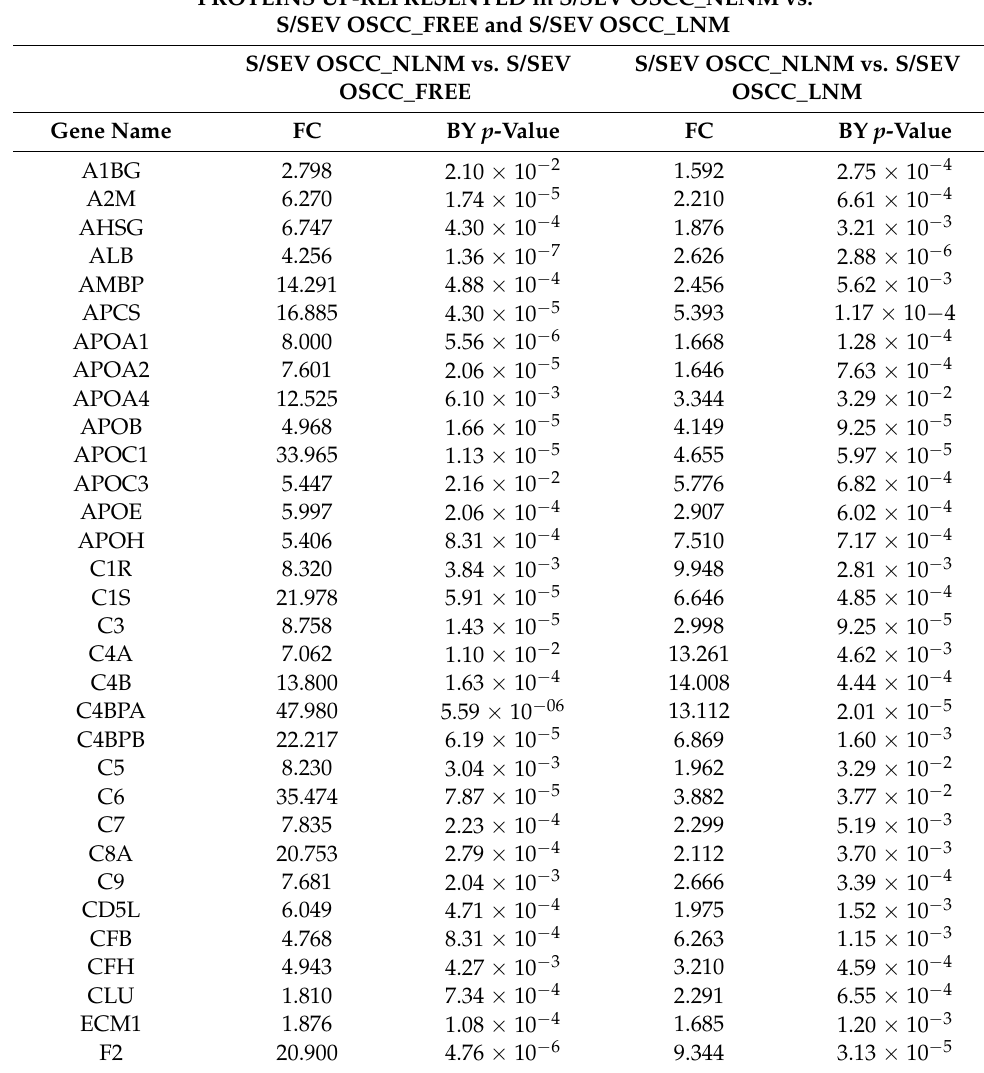
Table 6. Proteins specifically up-represented in S/SEV OSCC_NLNM. PROTEINS UP-REPRESENTED in S/SEV OSCC_NLNM